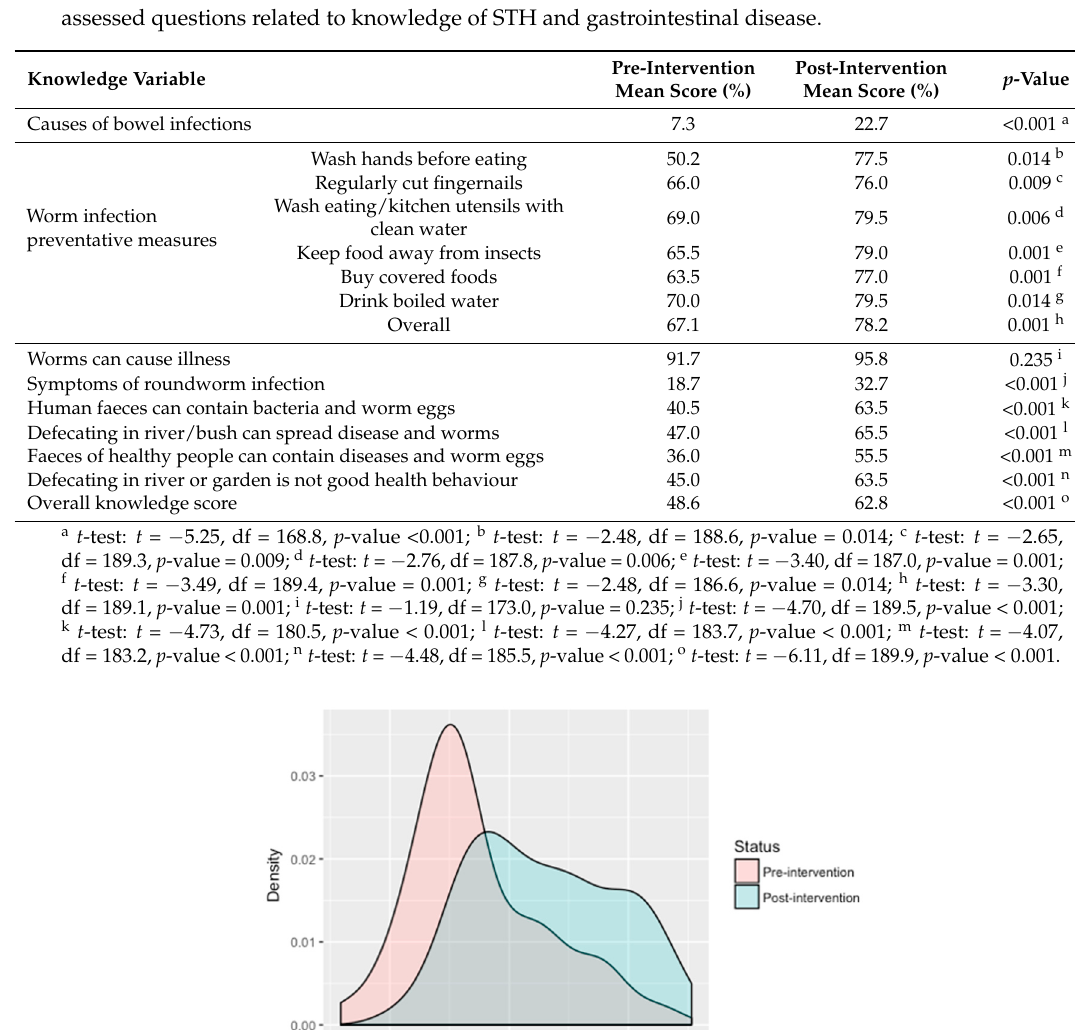
Table 2. Behaviour scores (as % of maximum number of points) pre- and post-intervention. Practices